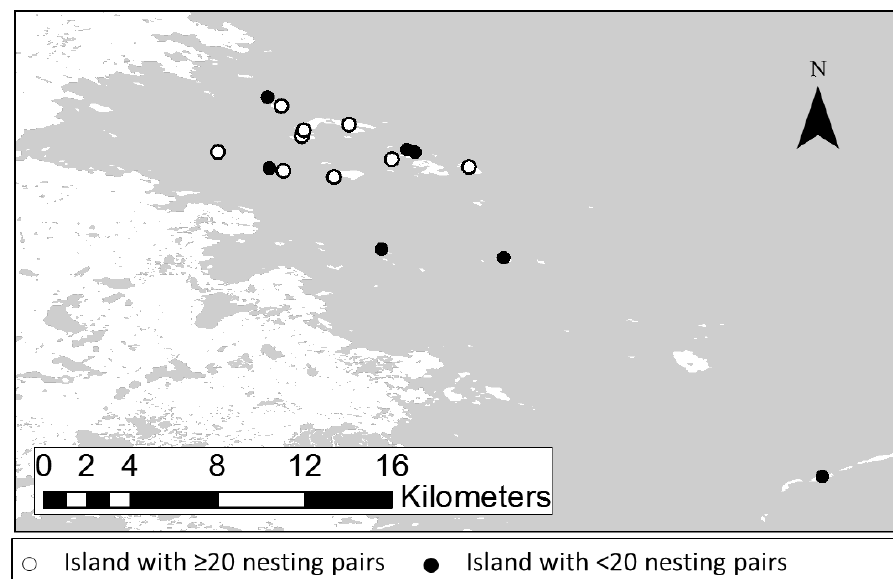
Figure A1.3. Survey zone 3: Plover Islands, Western Ungava Bay